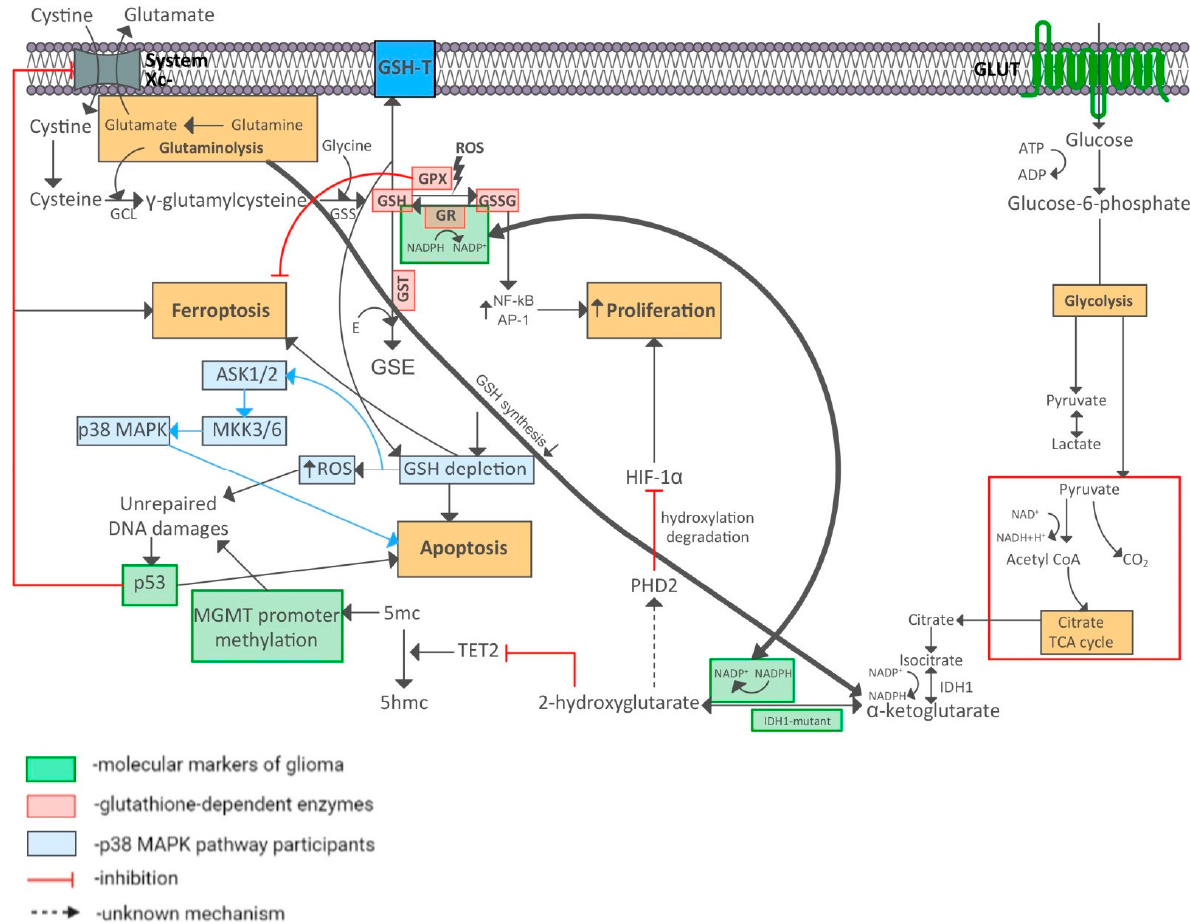
Figure 11. Diagram showing the relationships between gliomal molecular tumor markers and main enzymes involved in glutathione metabolism. GCL— γ -glutamyl-cysteine ligase; GSS—glutathione synthetase; GSH-T—glutathione transporter; system Xc—-cis-glu antiporter; E—electrophile; IDH— isocitrate dehyrogenase; GLUT—glucose transporter; PHD2—prolyl hydroxylase 2; HIF-1 α — hypoxia-induced factor 1 α ; MGMT—O-6-methylguanine-DNA methyltransferase; ROS—reactive oxygen species; GSH—reduced glutathione; GSSG—oxidized glutathione; GST—glutathione S- transferase; GPx—glutathione peroxidase; GR—glutathione reductase; GSE—glutathione conju- gate with electrophile; TET2—tet methylcytosine dioxygenase 2; 5mc—5-methylcytosine;